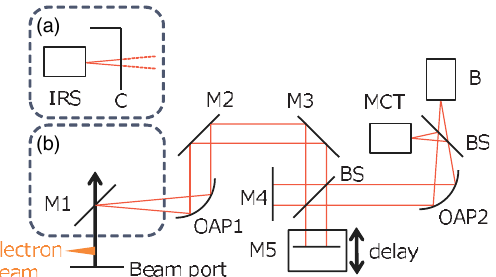
FIG. 2. Measurement system using a Michelson interferometer for (a) an infrared light source and (b) CTR from electron bunches. IRS: an infrared light source; C: an optical chopper (1 kHz modulation); M: a plane mirror; OAP: an off-axis parabolic mirror used for collimation and focusing on the detectors; BS: a beam splitter; MCT: a MCT photoconductive detector; B: a bolometer; beam port: a port made of titanium foil. Except for the detectors, all optics were set up in a vacuum chamber. The components surrounded with dashed lines [(a) and (b)] were designed to be switchable. M5 was placed on a delay stage for sweeping the mirror. The signal was acquired using a digital lock-in amplifier for the IRS measurement and an oscilloscope for CTR